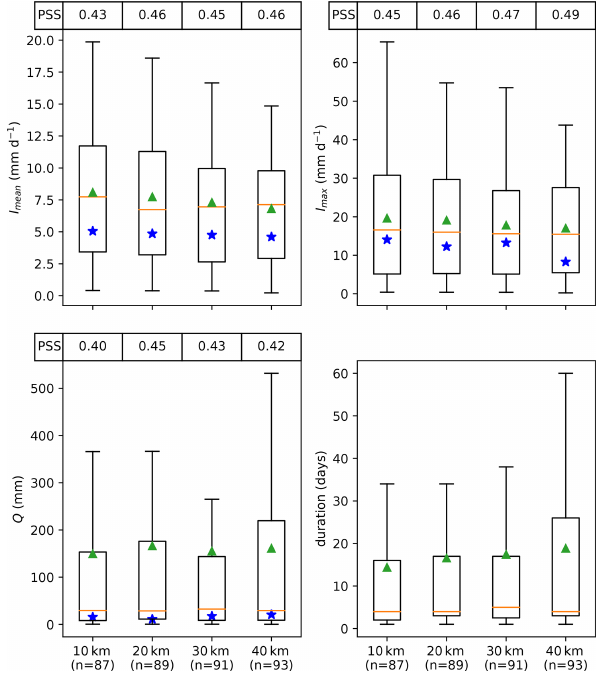
Figure 7. Boxplots demonstrating the impact of spatial resolu- tion of atmospheric data on I mean , I max , Q , and duration of LTE UTL events, as well as the associated landslide-triggering thresh- olds (blue stars). The yellow line denotes the median, and the green triangle indicates the mean. Outliers are not shown for a better inter- comparison, and n denotes the number of landslide events detected by rainfall +